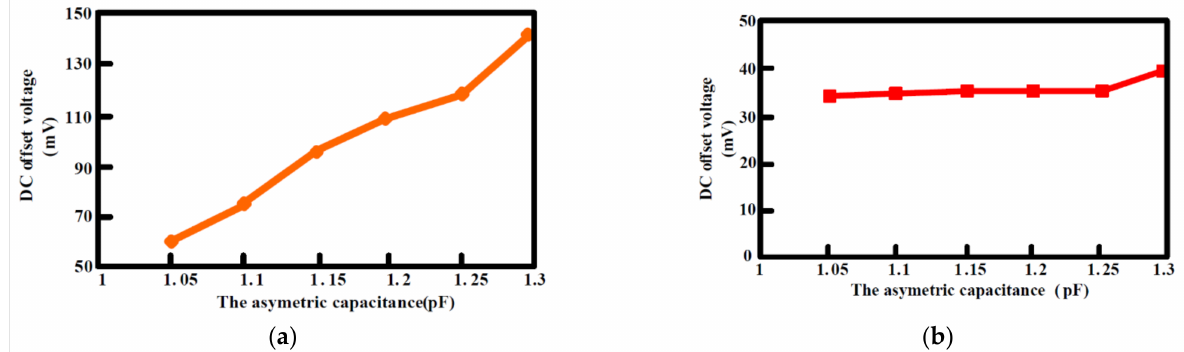
Figure 15. DC output voltage versus the asymmetric capacitance ( a ) without the digital chopping feedback loop; ( b ) with the digital chopping feedback loop.